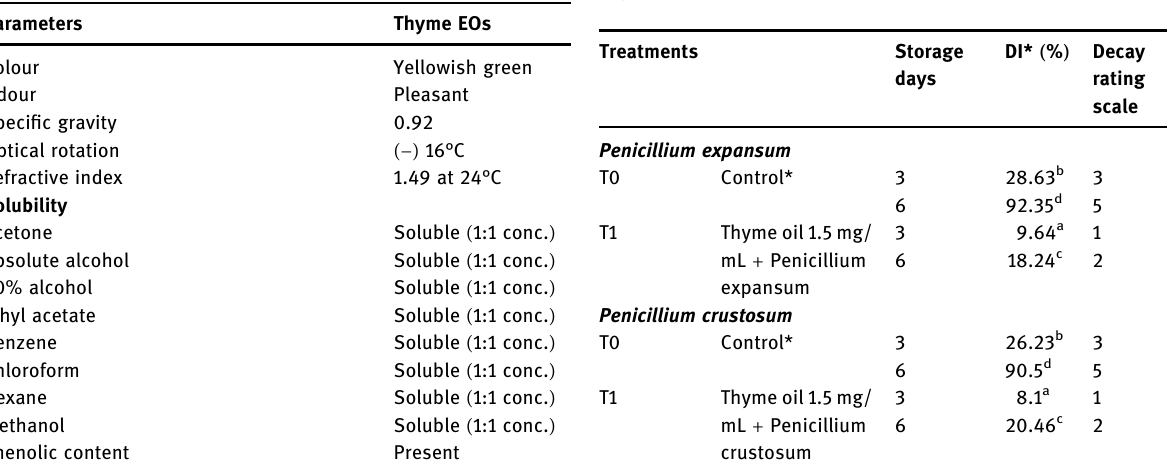
Table 9: E ff ect of thyme oil on DIP of Penicillium spp. after 3 and 6 days of